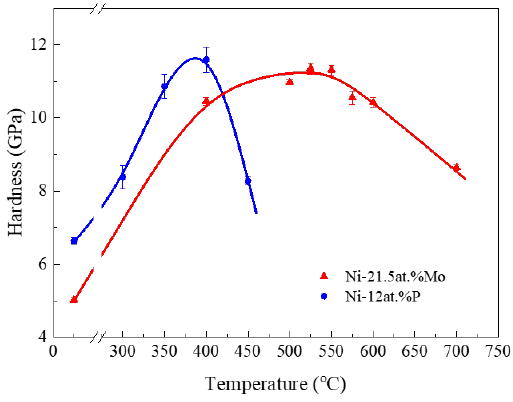
Figure 6. Variation of microhardness as a function of the annealing temperature with a duration of 1 h for ng Ni-21.5 at.% Mo (red line) and Ni-12 at.% P alloy (blue line).